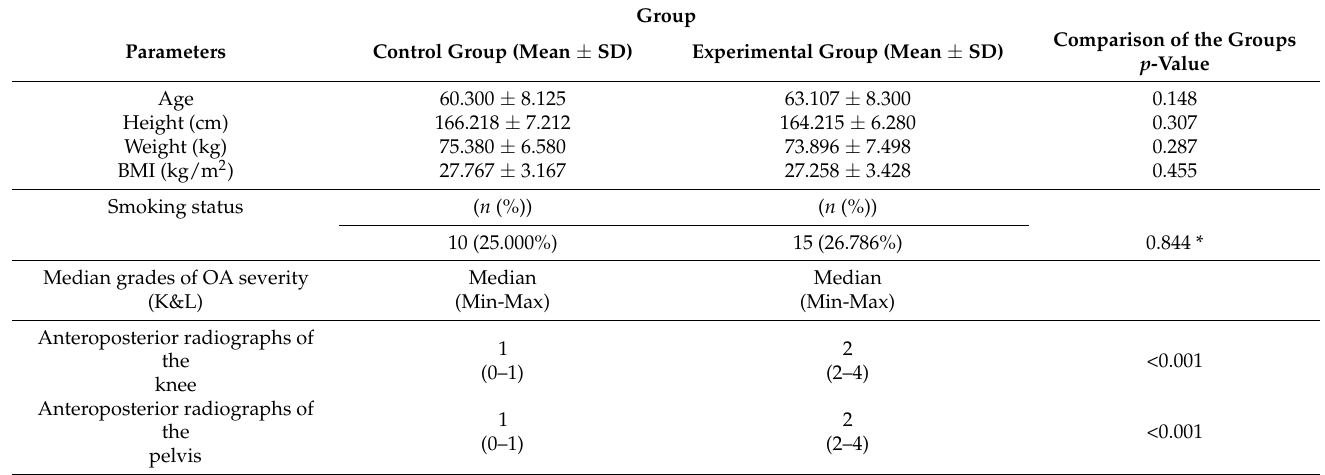
Table 1. Baseline characteristics and radiological median grades of OA severity in the experimental and control group.